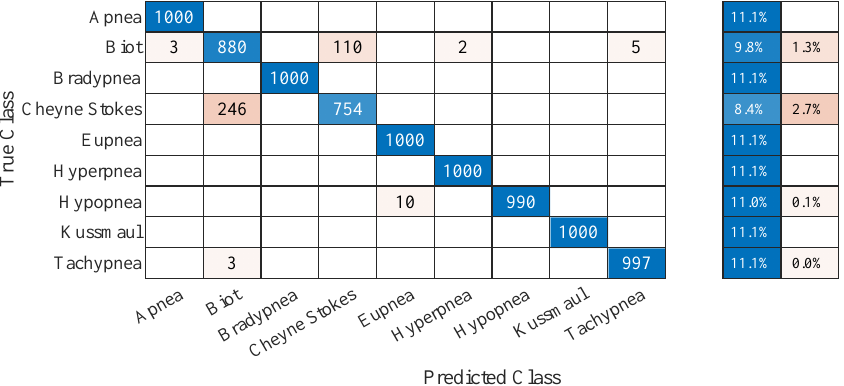
Figure 13. Confusion matrix for the one vs. one multiclass support vector machine breathing pattern classification of the respiratory signal extracted by chest feature tracking in thermal